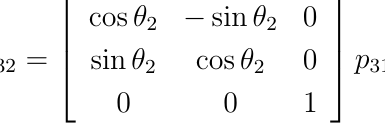
, is first moved 3 ( a ) and then moved 1